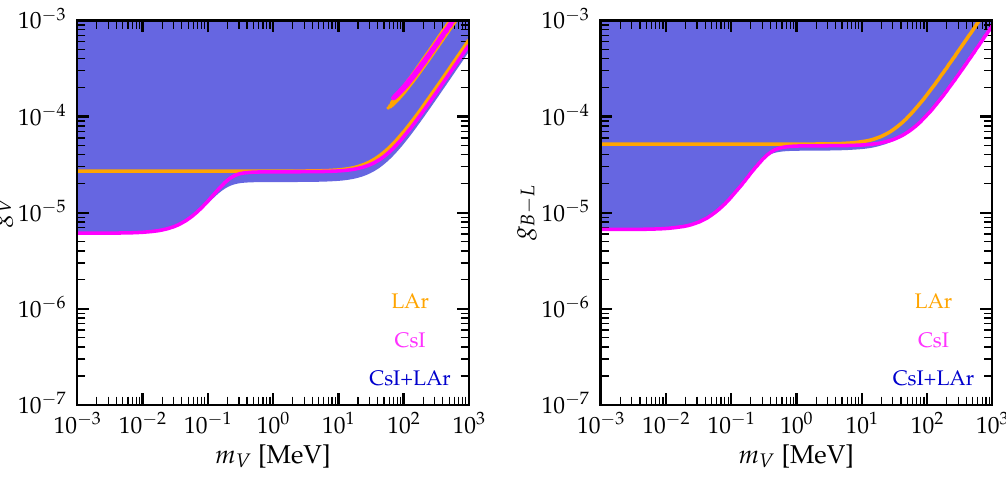
Figure 8 . 90% C.L. (2 d.o.f.) exclusion regions from the analysis of CsI (magenta), LAr (orange) and CsI + LAr (blue) data, for the universal light vector model (left) and the B-L scenario (right). The analysis of CsI data includes CE ν NS + ES